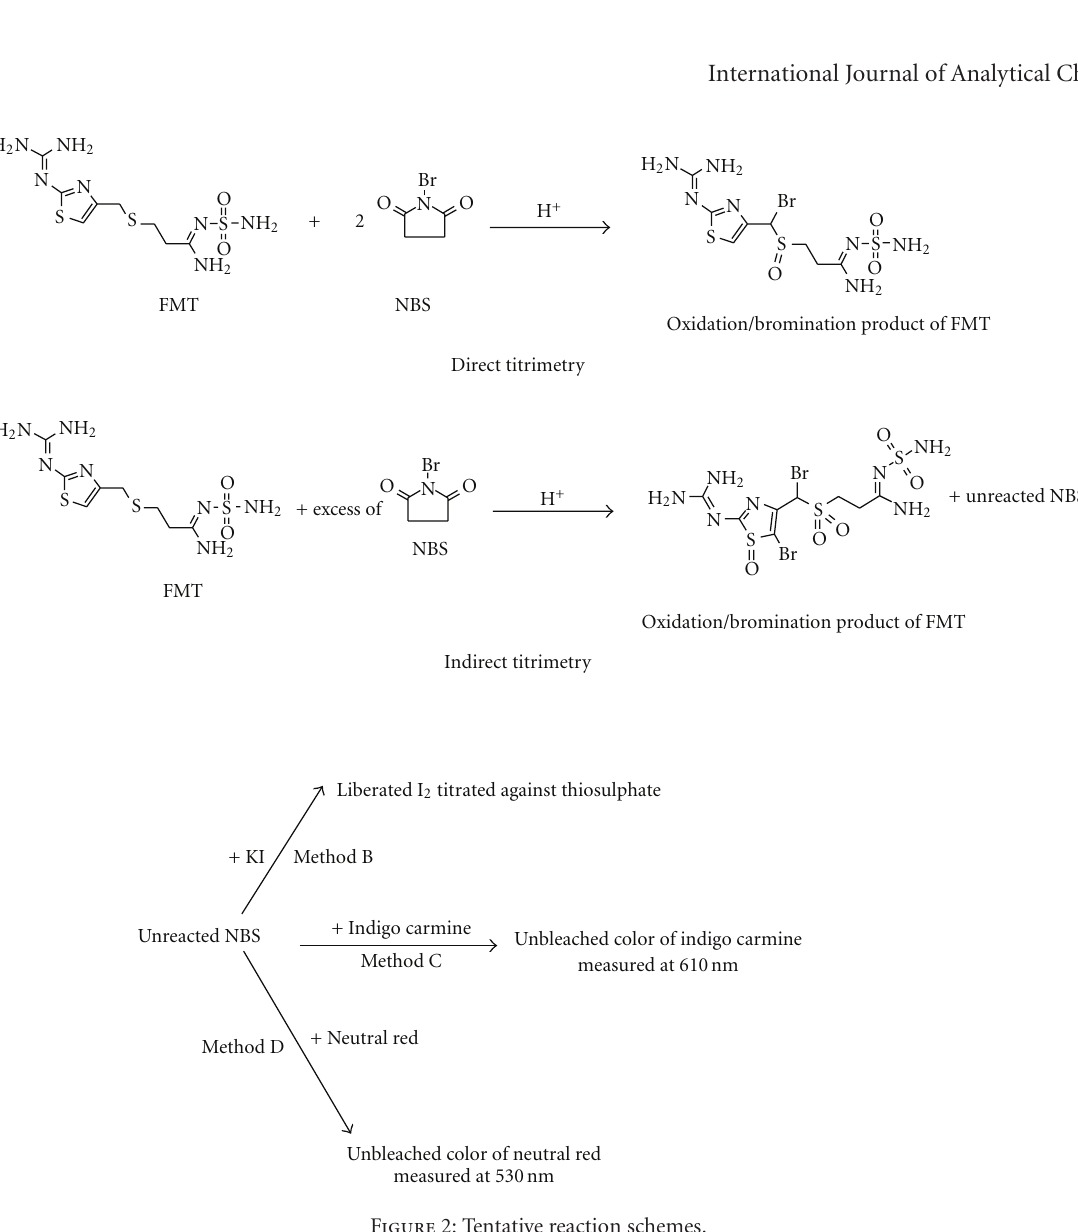
Figure 2: Tentative reaction